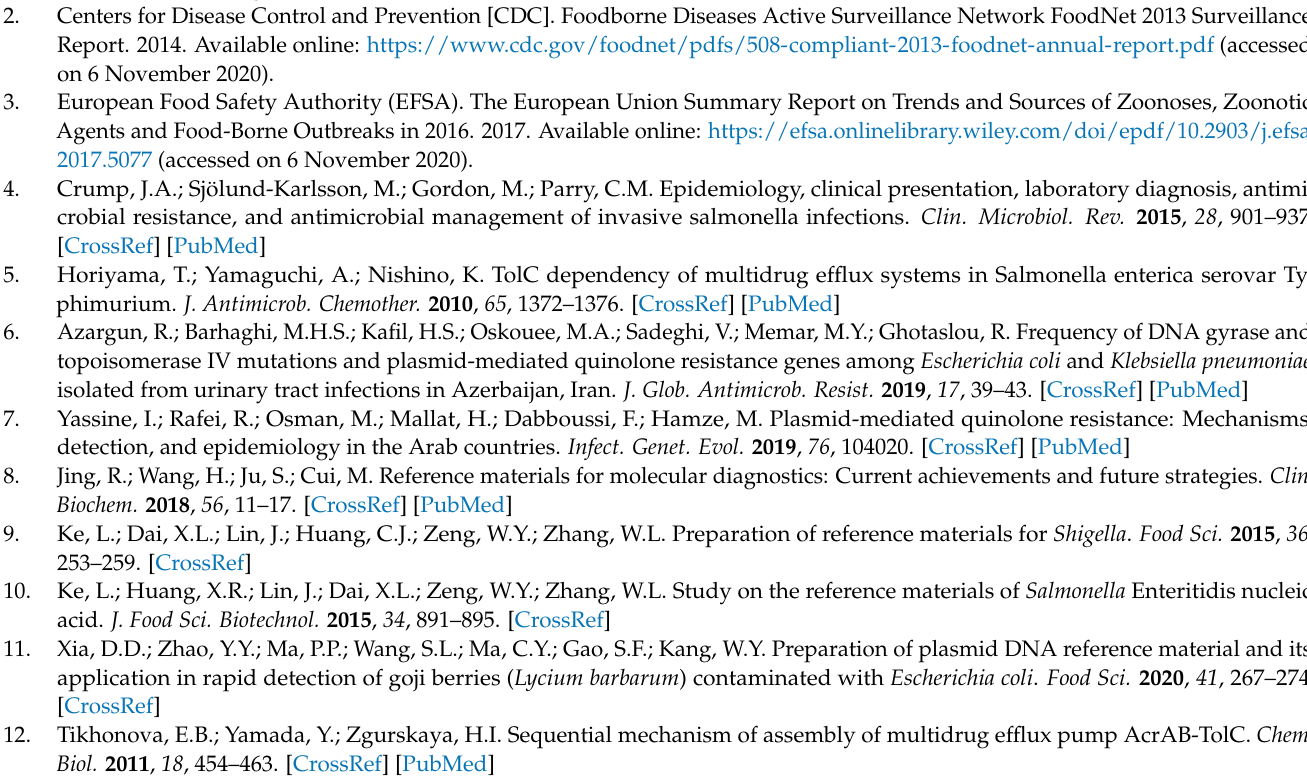
Figure S16: PCR results for storage stability of plasmid DNA references materials stored at 37 ◦ C; Supplementary Figures S17–S23: Sequencing results of aac(6 (cid:48) )-Ib , parC , qnrS , oqxA , qnrB , qnrA, and gyrA for stability of plasmid DNA references materials stored at 37 ◦ C, respectively; Supplementary Figure S24: PCR results for storage stability of plasmid DNA references materials stored at 4 ◦ C; Supplementary Figures S25–S31: Sequencing results of aac(6 (cid:48) )-Ib , parC , qnrS , oqxA , qnrB , qnrA , and gyrA for stability of plasmid DNA references materials stored at 4 ◦ C, respectively; Supplementary Figure S32: PCR results for storage stability of plasmid DNA references materials stored at − 20 ◦ C; Supplementary Figures S33–S39: Sequencing results of aac(6 (cid:48) )-Ib , parC , qnrS , oqxA , qnrB , qnrA ,